Question: How would you classify this visualization?
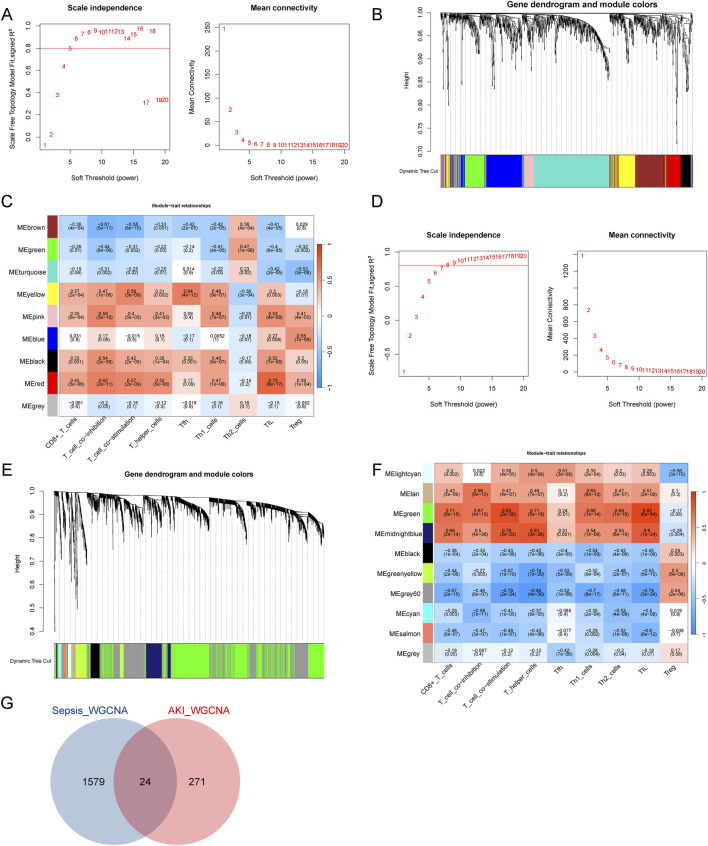
Answer: heatmap